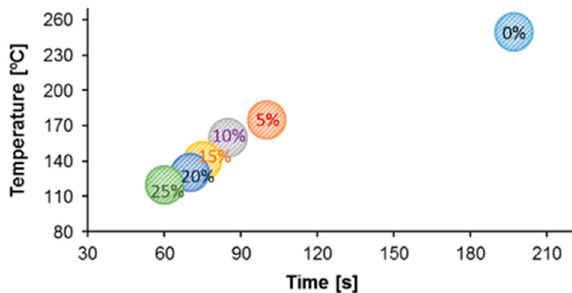
Figure 13. Results from debonding evaluation test (followed induction heating at 250 ◦ C) employing a commercial adhesive used in the automotive industry (Betamate ™ 2098). Temperature ( ◦ C) versus time for debonding. Percentage shows the amount (wt%) of TEP in the adhesive. The more filler that is added, the faster the bond fails and the lower the failing temperature [199]. Reprinted from International Journal of Adhesion and Adhesives, Vol 59, Banea et al. “Debonding on command of adhesive joints for the automotive industry”, Pages No 14–20, Copyright (2015), with permission from Elsevier.